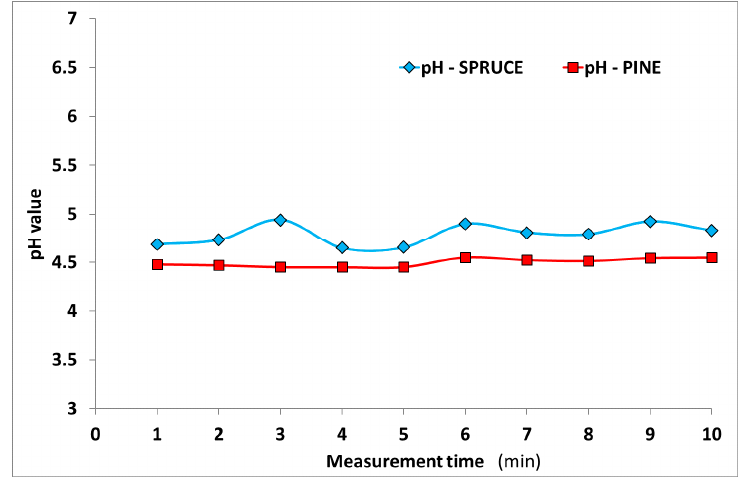
Figure 2. The pH value of the wood surface—spruce and